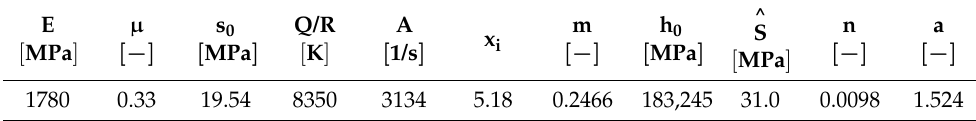
Table 2. Initial parameters of the Anand material